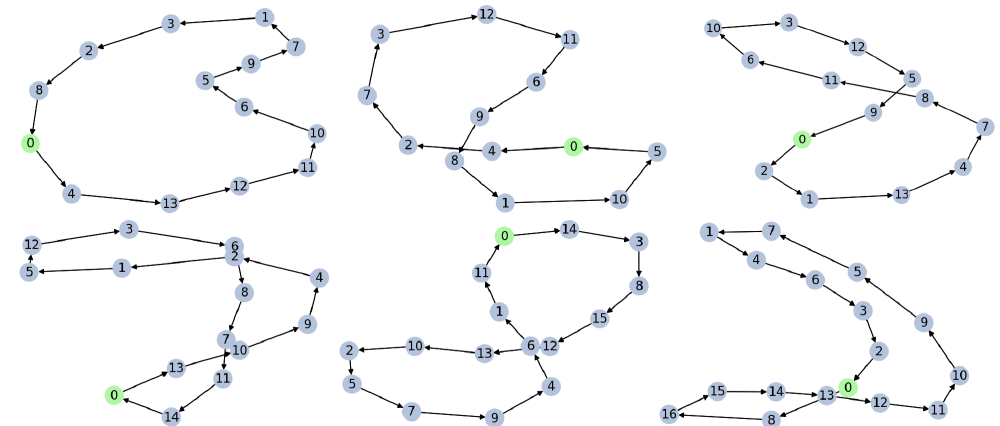
Figure 2. In these graphs, we can observe the algorithm’s results in different scenarios of the GPS formulation. We can follow the correct scalability of the algorithm. We provide the code [50] to check its proper functioning and to allow others to simulate lower values or values higher than N = 16.